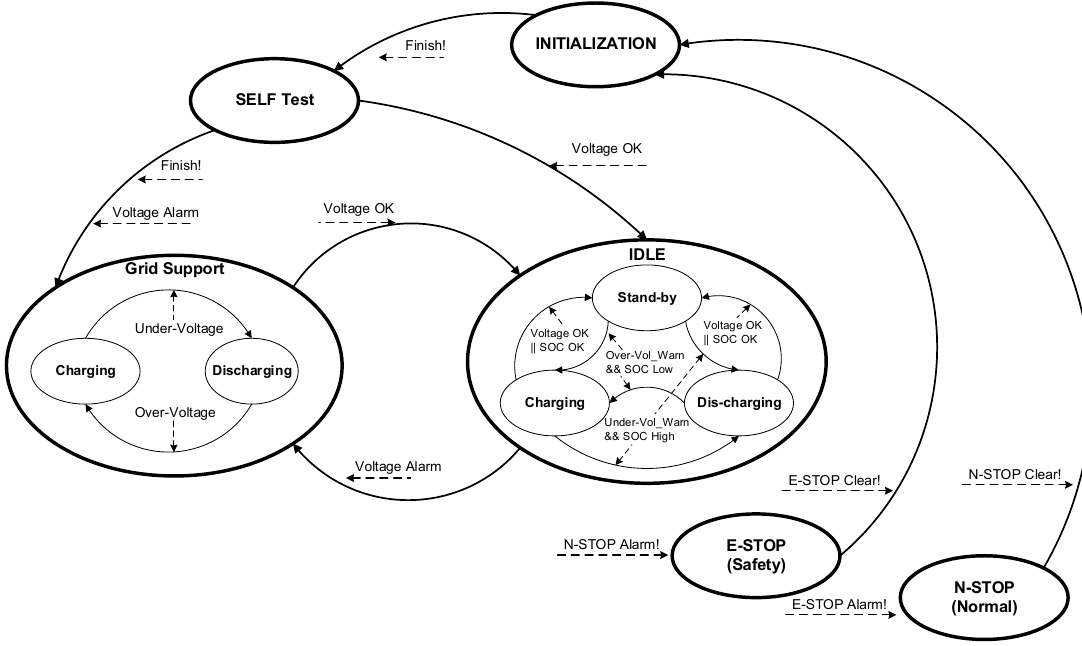
Figure 14. State machine of the energy management system (EMS) for EV charging infrastructure.